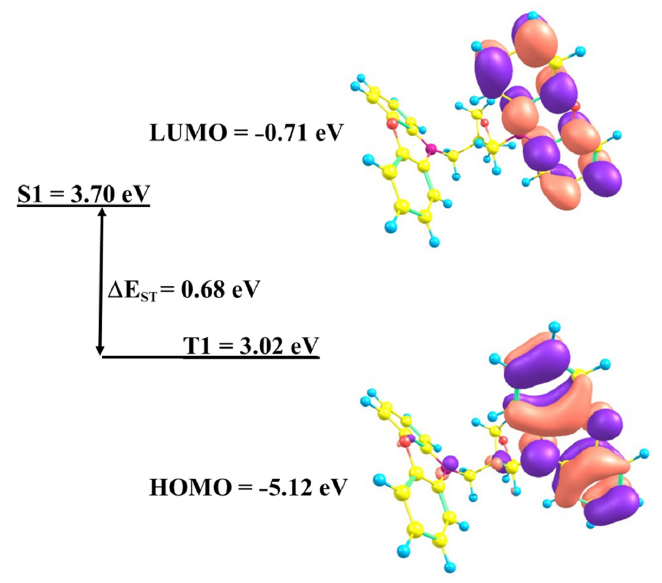
Figure 1. The HOMO (–5.1 eV), LUMO (–0.7 eV), and triplet energy (3.0 eV) of BPMO host theoretically calculated using DFT. Table 1. A comprehensive list of photophysical and electrochemical properties of hosts BPMO and CBP for emission wavelength, melting temperature, glass-transition temperature, decomposition temperature, HOMO, LUMO, singlet/triplet energies, and bandgap.